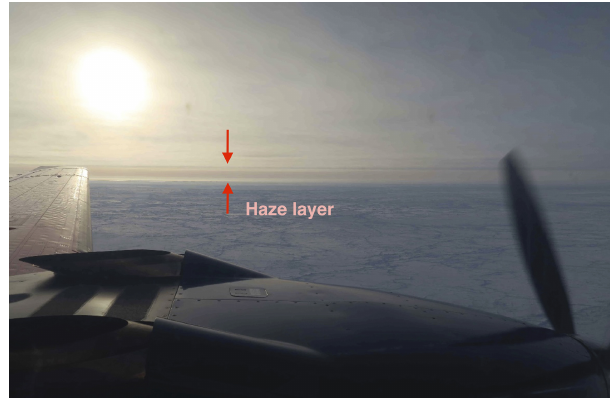
Figure E1. Photo taken from the research aircraft POLAR 5 on 3 April 2018. A haze layer with reddish color, which may corre- spond to the plumes, was